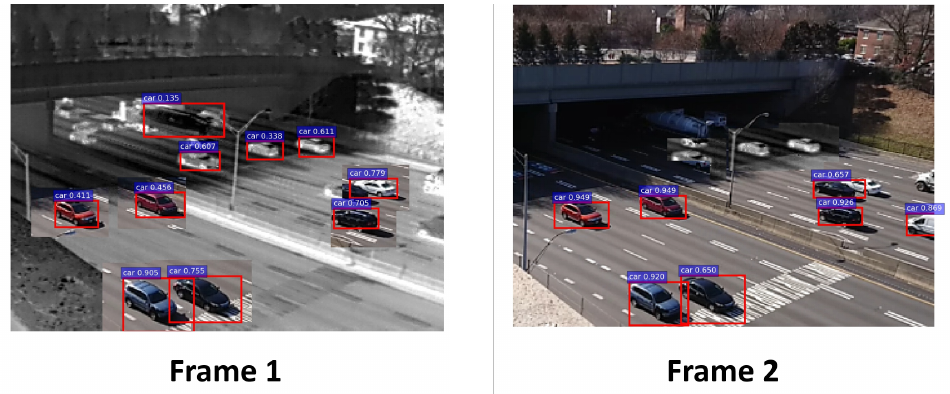
Figure 1. Problems with confidence-driven control in a multi-modal sensor. The truck on the top region of the frame gets rejected due to a low confidence (0.135). The detection, however, has a high level of uncertainty. The uncertainty information can be exploited to keep this region in